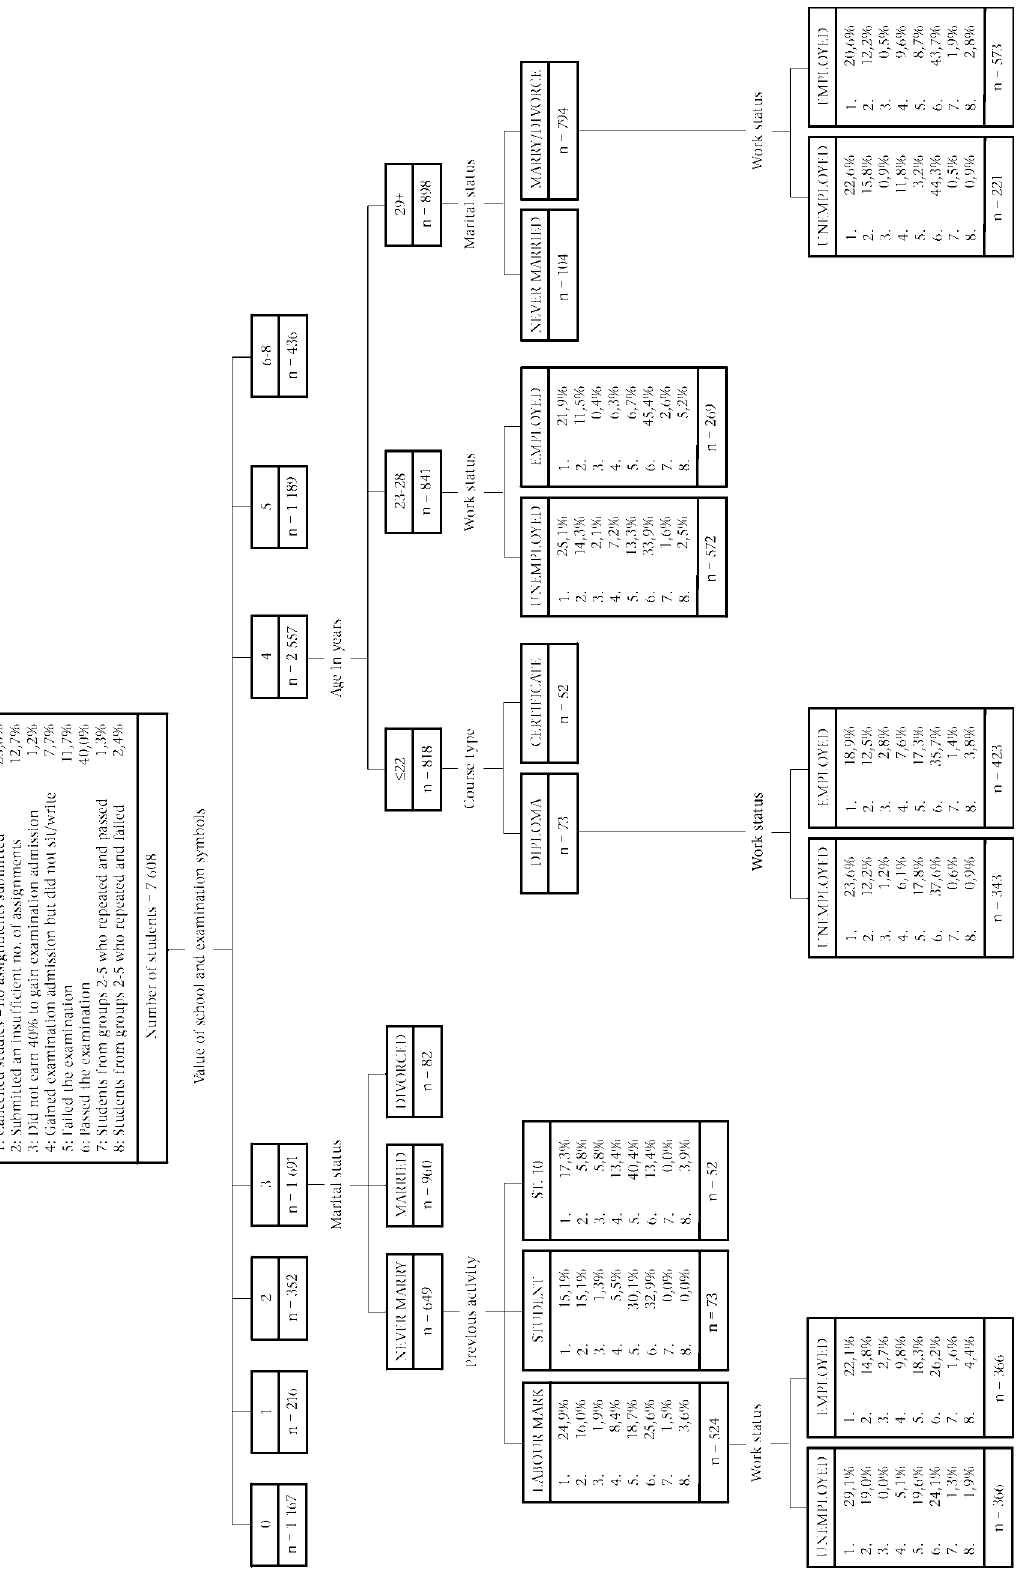
Figure 3: Dendogram of the white student